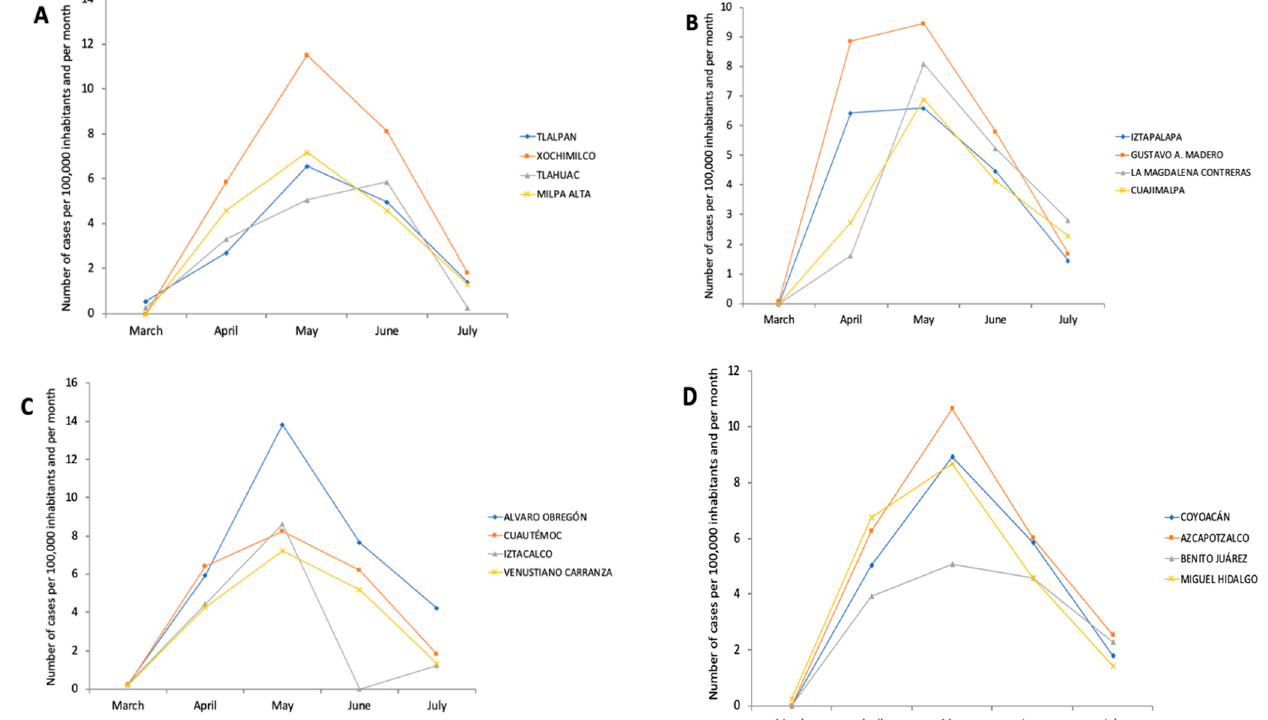
Figure 4. Exponential growth of COVID-19 cases per major divided by SWI categories and per 100,000 inhabitants, between March–July 2020. ( A )—Low-SWI, ( B )—Medium-SWI, ( C )—High-SWI, ( D )—Very High-SWI.